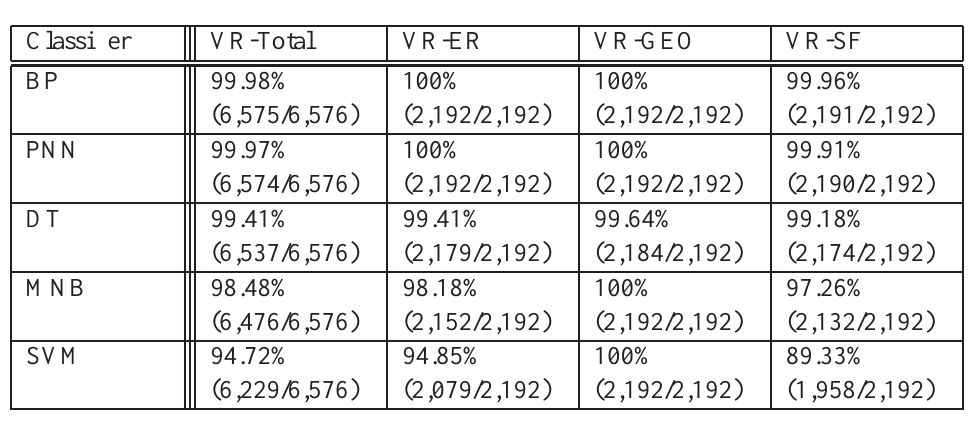
Table S1: The validation rates (“VR”) for the five classifiers, BP, PNN, DT, MNB, and SVM (col- umn 1), over the entire testing set of 6,576 ER, GEO, and SF networks (column 2), as well as within each individual testing subset of 2,192 ER, 2,192 GEO, or 2,192 SF networks (columns 3–5,